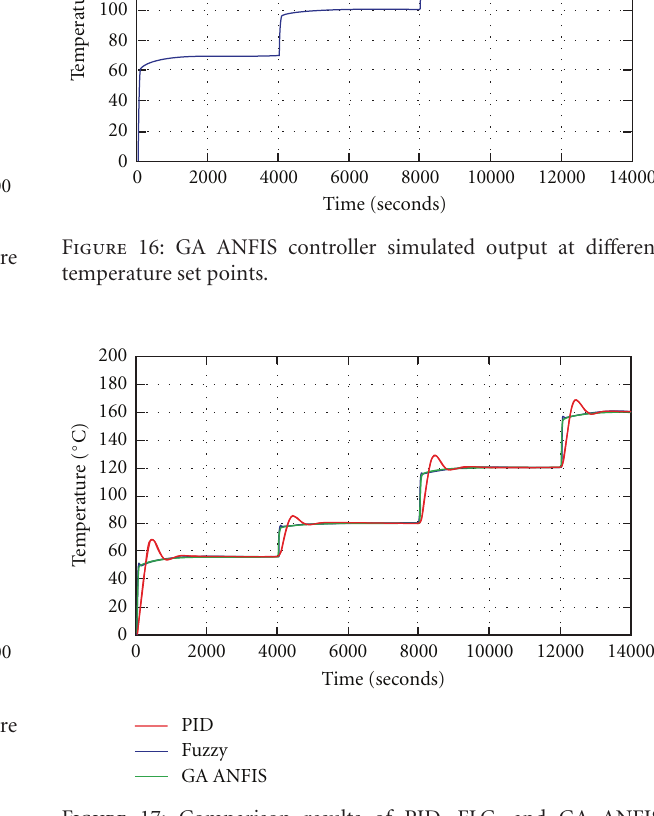
Figure 17: Comparison results of PID, FLC, and GA ANFIS